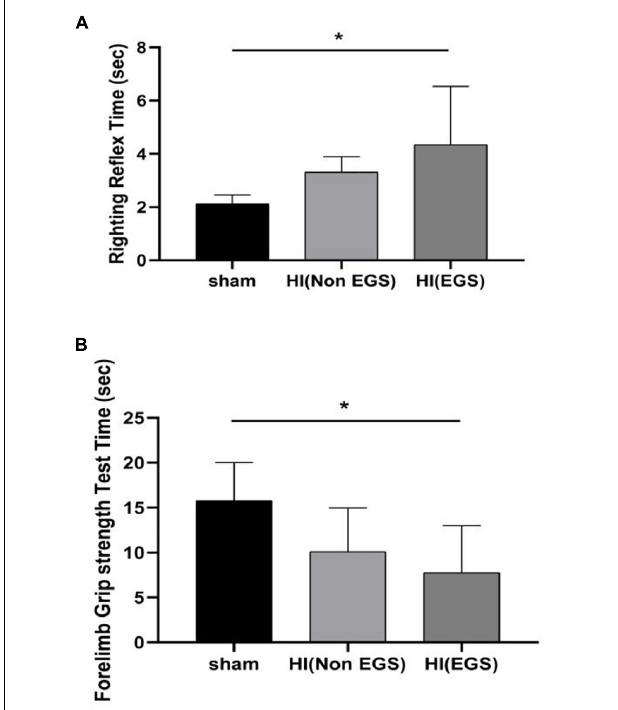
FIGURE 4 | Neurobehavioral development evaluation of rats. Hypoxia–ischemia (HI) rats were divided into HI (Non-EGS) and HI (EGS), according to whether the electrographic seizures (EGS) occurred at 72 h following HI induction. The day age of the sham group rats is postnatal day 6. (A) Righting reflex test. (B) Forelimb grip strength test. * p <